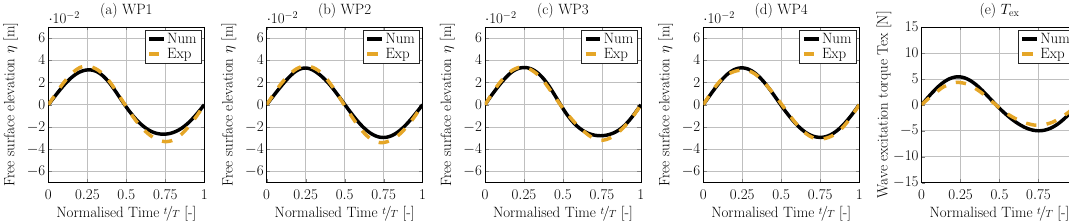
Figure 10. Phase-averaged free surface elevation, measured at wave probes WP1–WP4 ( a – d ), and wave excitation torque ( e ) for wave RW2.